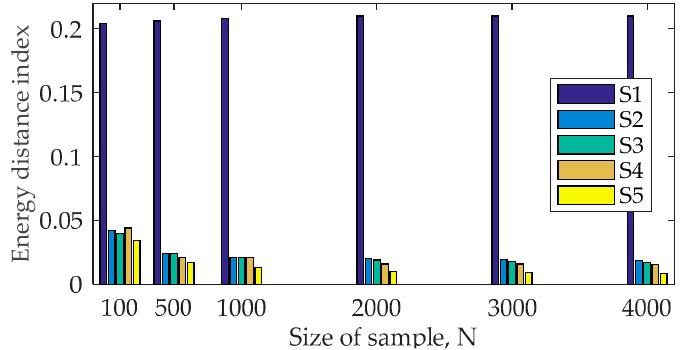
Figure 10. Energy-based sensitivity indices versus sample size 𝑁 .